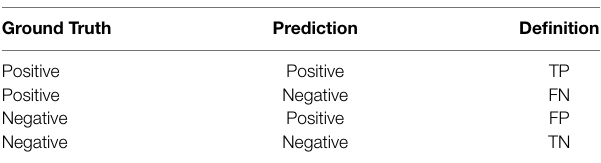
TABLE 2 | Definition of confusion matrix.